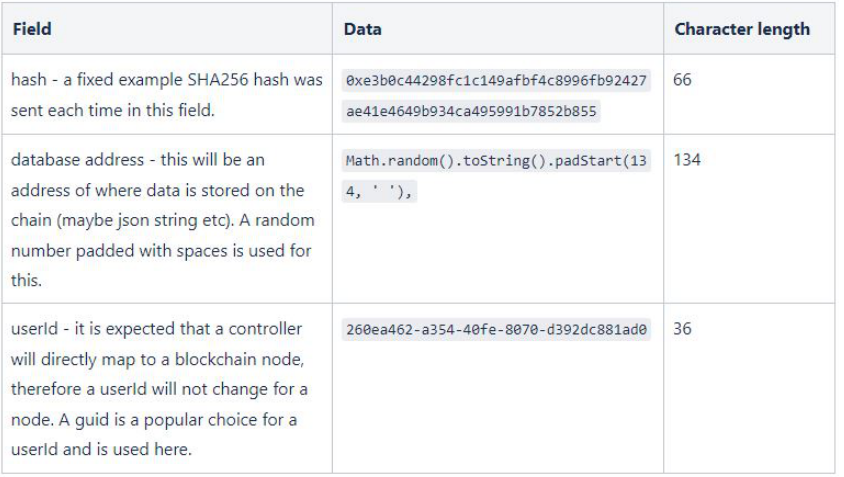
Figure 5. Transaction data.